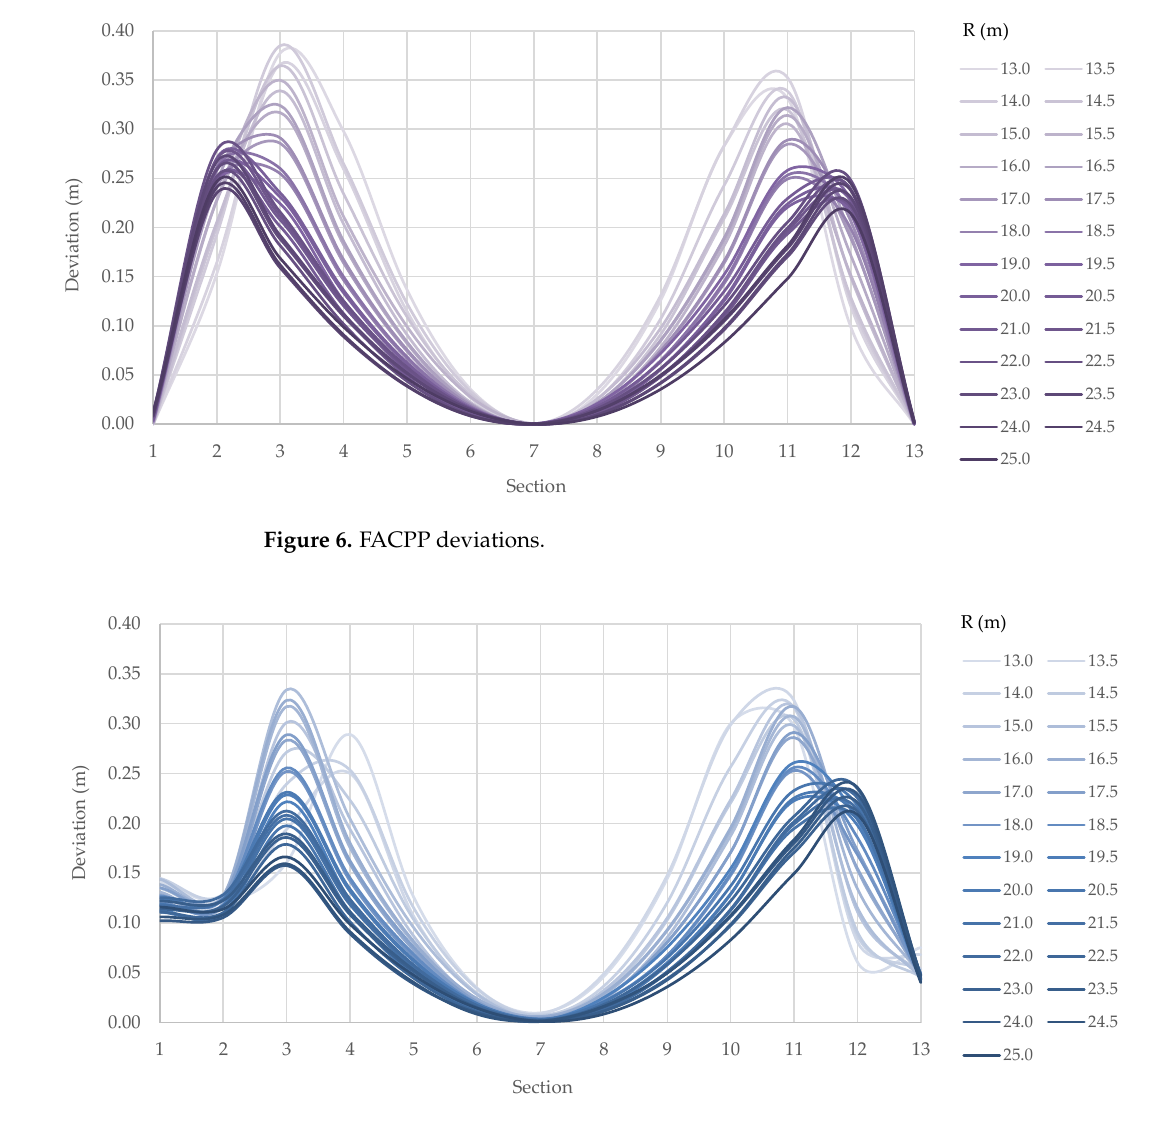
Figure 7. Chassis right-hand-side trajectory deviations. The largest deviations (which do not exceed 0.35 m) for roundabouts with small outer radii are again noted at cross-sections 3 and 11 (Figure 7). Meanwhile, at roundabouts with outer radii of 13.0, 13.5, and 14.0 m, larger deviations are noted at cross-section 4. With an increase in R, a decrease in deviations is noted. Cross-section 3 remains the one with maximum deviations on the circulatory roadway entry, while cross-section 12 be- comes the one with maximum deviations on the circulatory roadway exit. Deviations un- der 0.05 m are noted at cross-sections 5–9 and 13. This was expected for cross-section 7 because it transverses point B, which is a common point for analyzed paths. Deviations